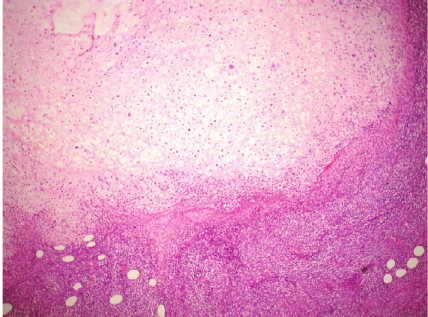
Figure 3: Microscopic histopathology of the tumour showing chondrosarcomatous transformation ( × 100 magnification).